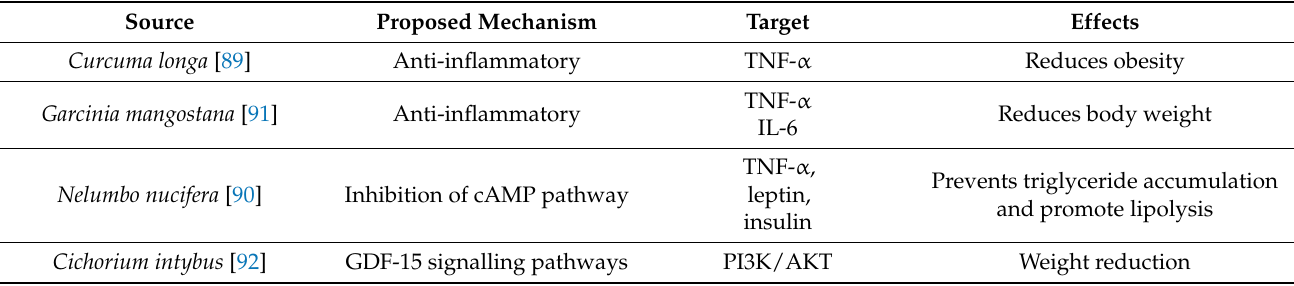
Table 7. Herbal extracts acting on TNF- α